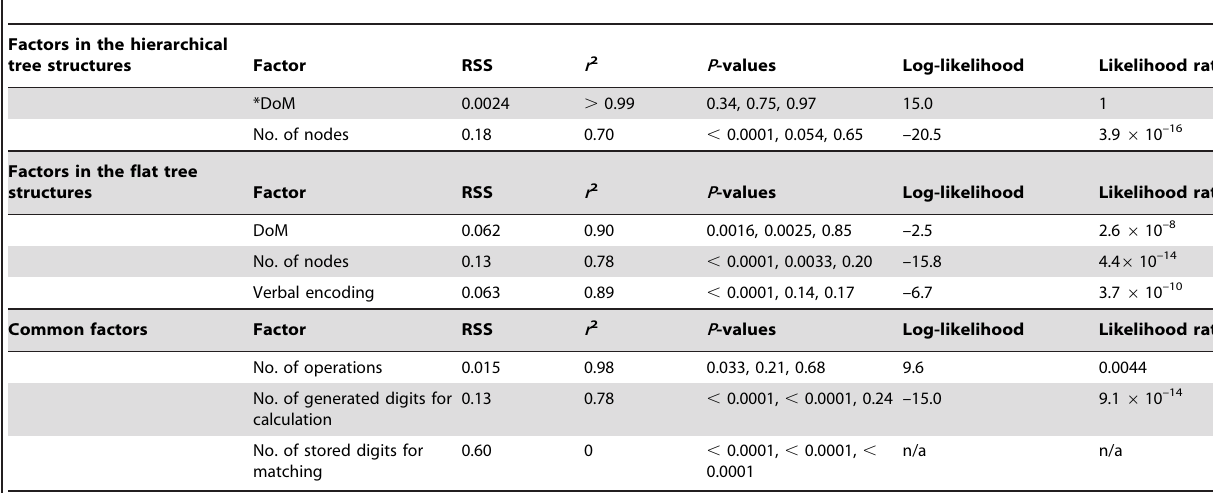
Table 5. Fittings and likelihood of various models tested in the L.